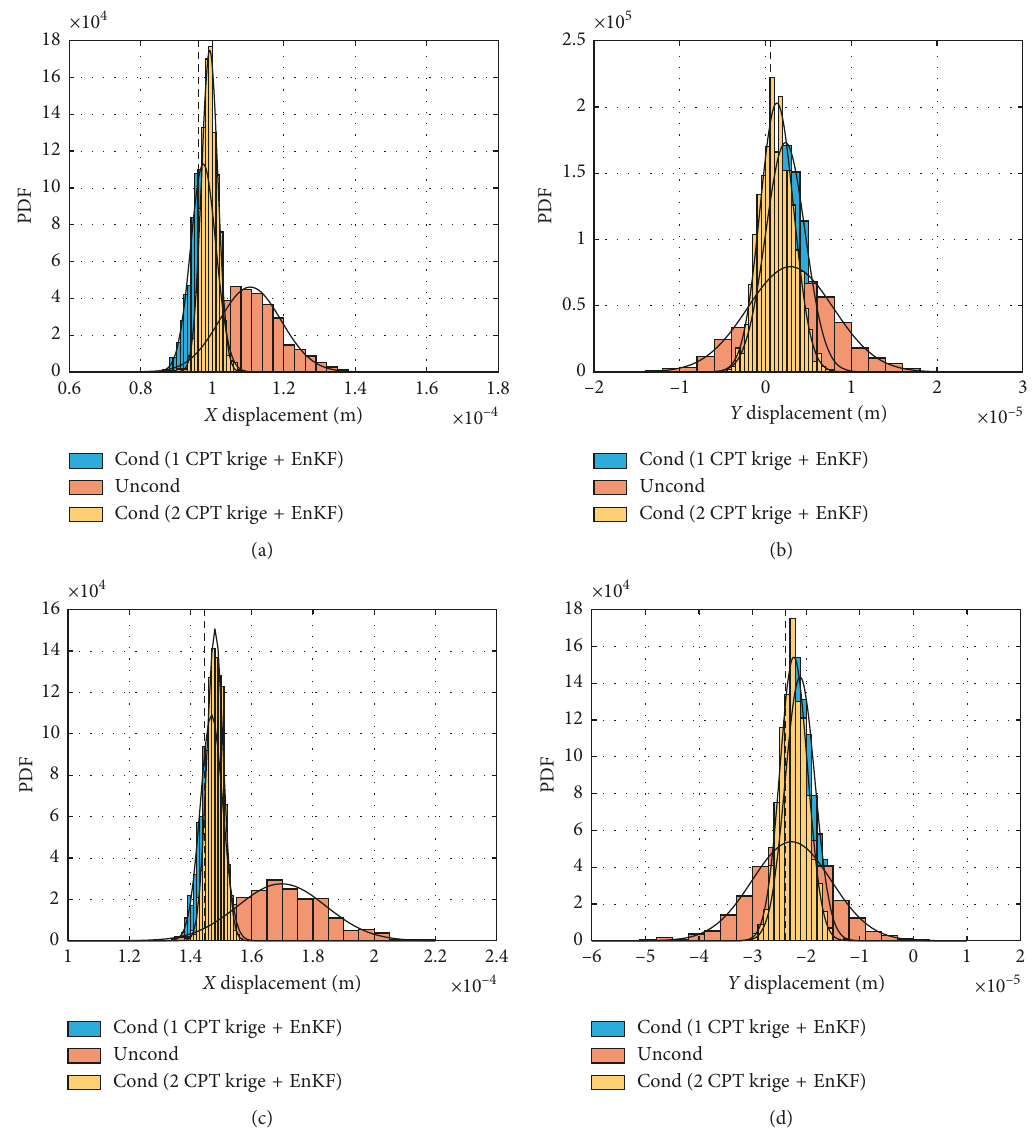
Figure 10: PDF of target point displacements in excavation steps 2-3: comparison between unconditional simulation and conditional simulation based on CPTand displacement measurements. (a) Second layer excavation ( X ), (b) second layer excavation ( Y ), (c) third layer excavation ( X ), and (d) third layer excavation ( Y